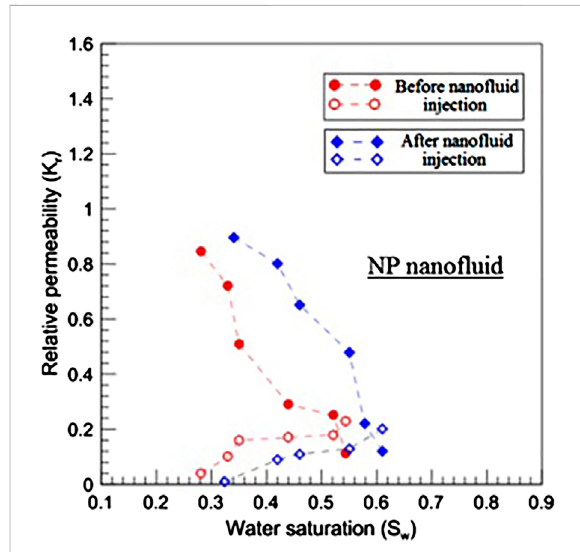
FIGURE 12 Relativepermeabilitycurves forbrine (emptysymbols) andoil ( fi lled symbols) before and after nanoparticle-added polymer fl ooding (Sharma et al., 2016).